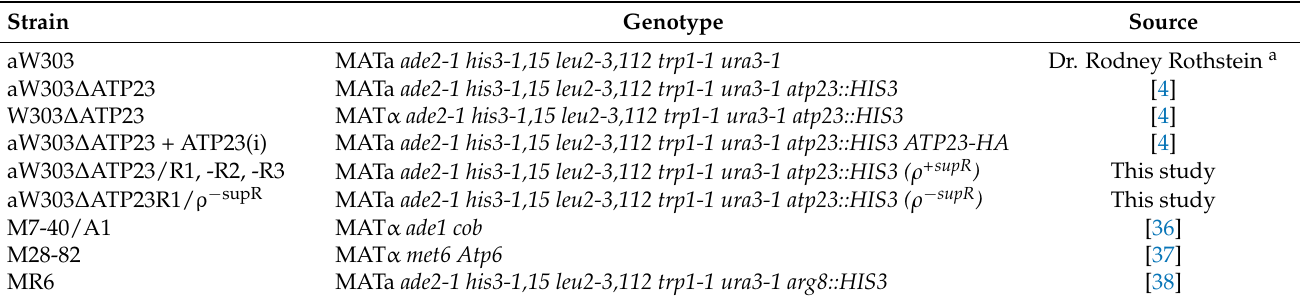
Table 3. Genotypes and sources of yeast